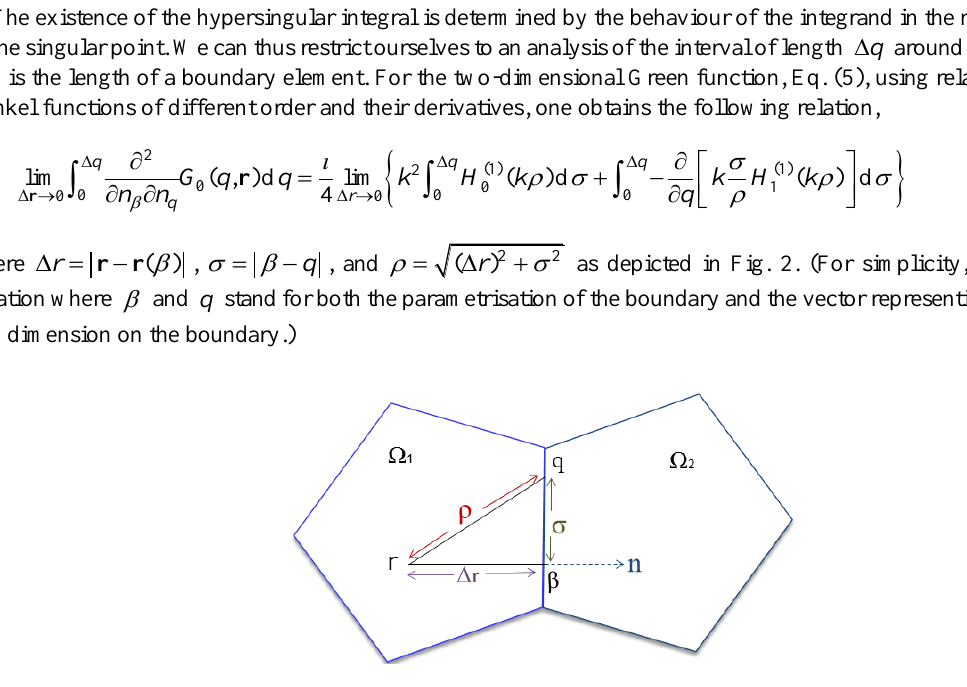
Fig. 2. Geometrical illustration of an interior point r approaching a boundary point  ,